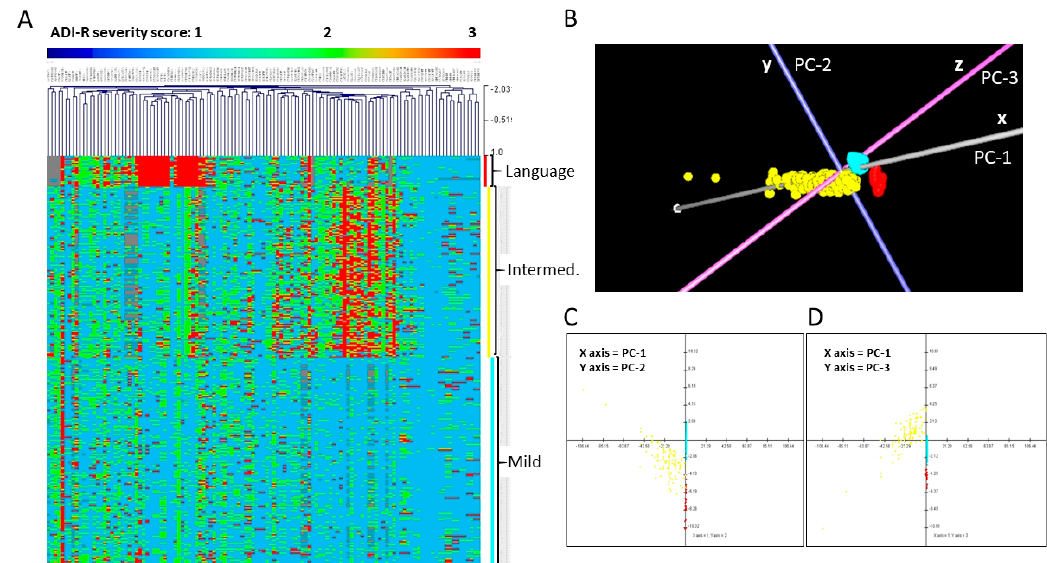
Figure 1. Separation of probands into three phenotypic subgroups based on cluster analyses of 123 scores on 63 Autism Diagnostic Interview-Revised (ADI-R) items for each individual. ( A ) Hierarchical clustering (HCL) analysis, ( B – D ) Principal components analysis (PCA) in 3-d ( B ) and 2-d projections showing PC-1 and PC-2 (C) and PC-1 and PC-3 (D). For the heatmap in ( A ), each row represents an individual, while each column represents a score from the ADI-R diagnostic. The range of severity scores (1–3) for each ADI-R item is represented in the color bar above the heatmap, with light blue indicating a score of 1, green-yellow indicating a score of 2, and red indicating a score of 3, which represents the most severe autism spectrum disorder (ASD) manifestation. The three ASD subgroups are identified by the vertical colored bars along the right side of the heatmap, with red indicating the severely language-impaired subgroup, yellow indicating the intermediate subgroup, and turquoise indicating the mild subgroup. This latter set of colors also applies to the subgroups shown in the PCA plots in which each point represents an individual. Note: In the heatmap ( A ), the large block of red columns associated with the severely language-impaired subgroup primarily corresponds to items involving spoken language on the ADI-R diagnostic.